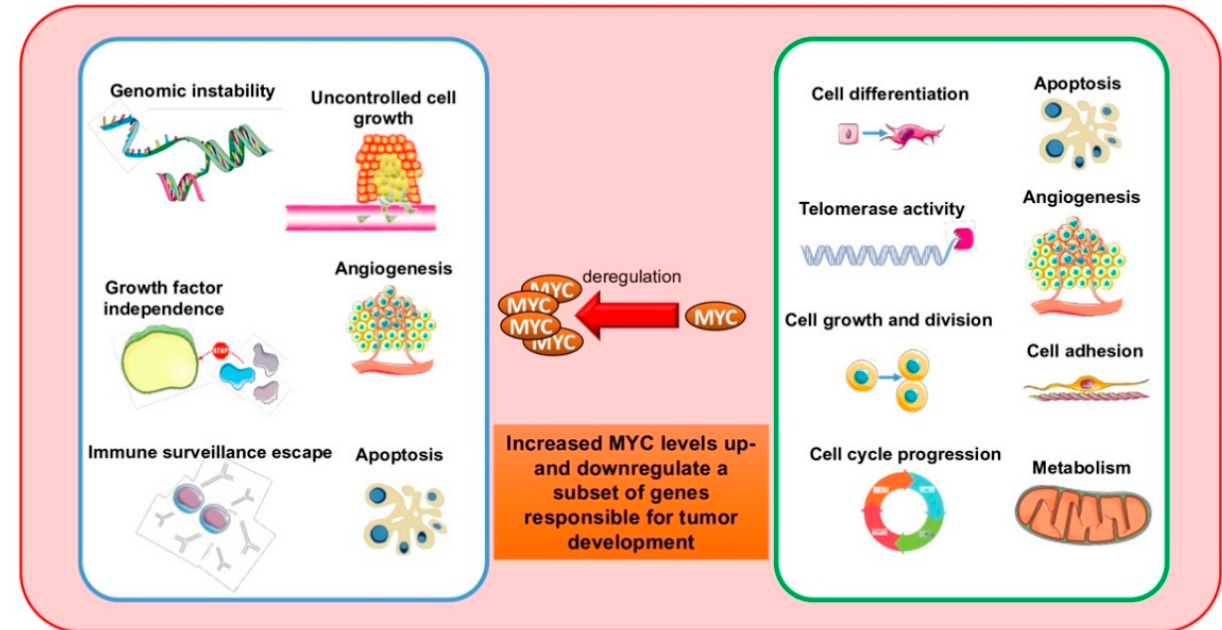
Figure 1. MYC regulation of distinct cellular functions. Many biological processes are regulated by MYC. Elevated MYC levels can result in deregulation of a subset of genes involved in cancer de- velopment.